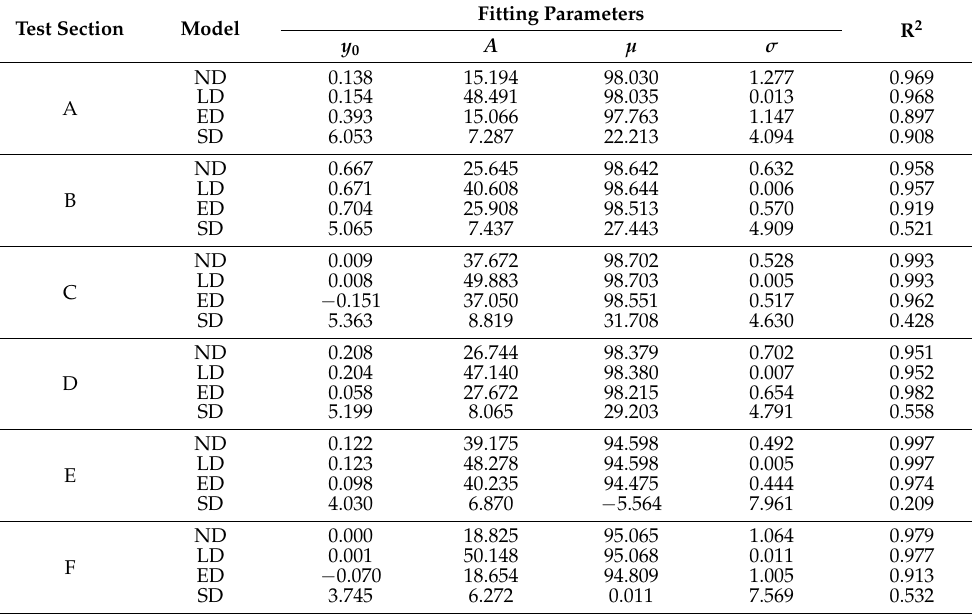
Table 5. Fitting parameters of the probability distribution